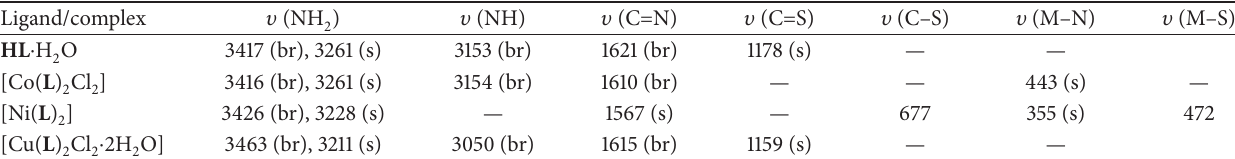
Table 2: Infrared vibrational bands (cm − 1 ) of ligands and their complexes with tentative assignment.